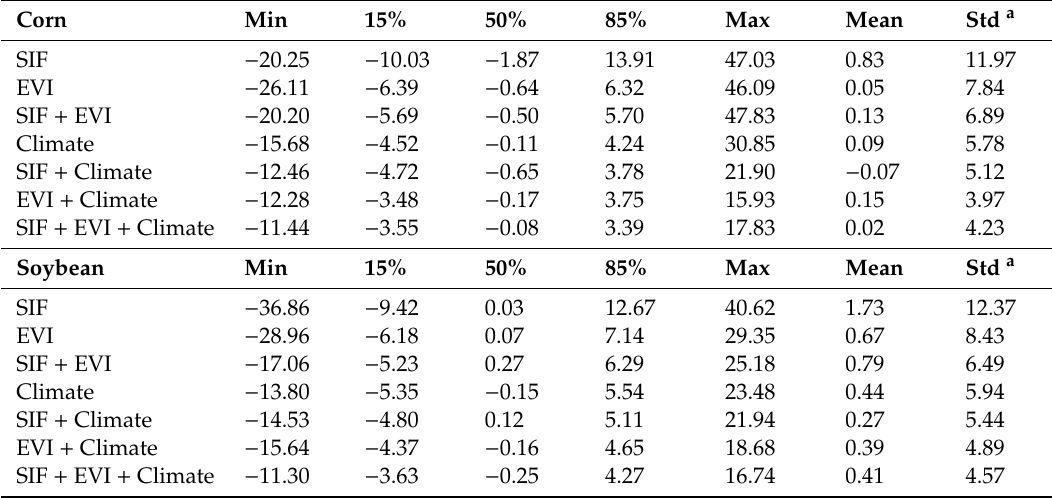
Table 2. Summary of the percentage error (PE) of county-level yields estimated by di ff erent models in the 12 Midwest states. Values fall into columns of 15%, 50%, 85% are the PE at the 15th, 50th (or median), and 85th